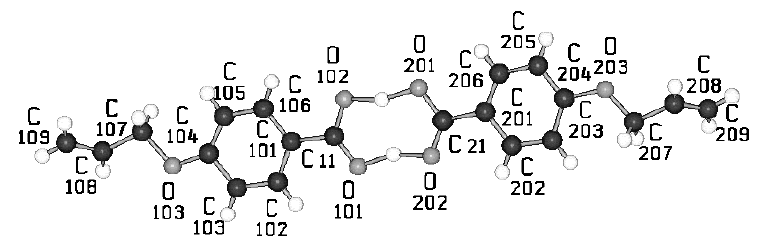
Figure 16. Representation of the conformations of two molecules of PROBA as asymmetric unit with the numbering of the atoms and the projections of the packing arrangement in space group P2 along [100] and the diagonal of the 1